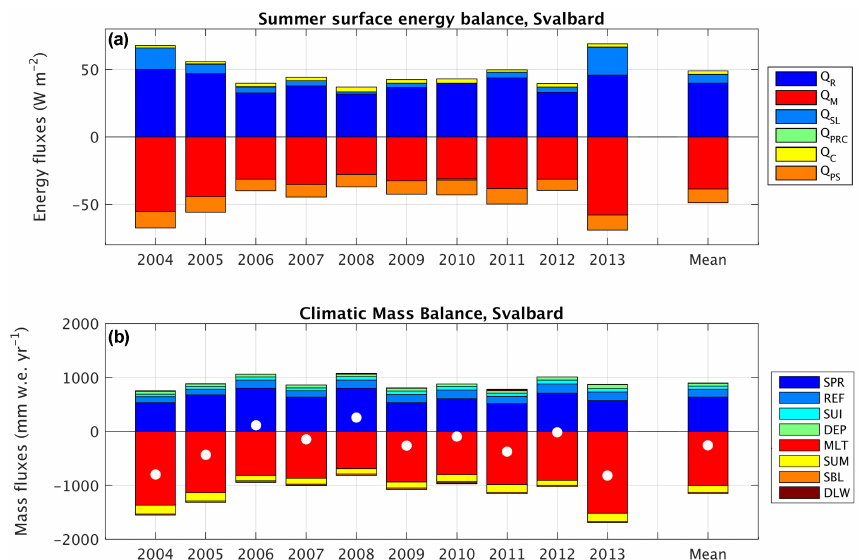
Figure 10. (a) Mean summer (JJA) surface energy balance fluxes. Q R : net radiation; Q M : melt energy; Q SL : sensible and latent heat flux; Q PRC : heat from precipitation; Q C : ice heat flux; Q PS : penetrating solar radiation. (b) Annual mass fluxes averaged over Svalbard. SPR: solid precipitation; REF: refreeze; SUI: superimposed ice; DEP: deposition; MLT: surface melt; SUM: subsurface melt; SLB: sublimation; DLW: change in snow liquid water. The resulting CMB is indicated by white